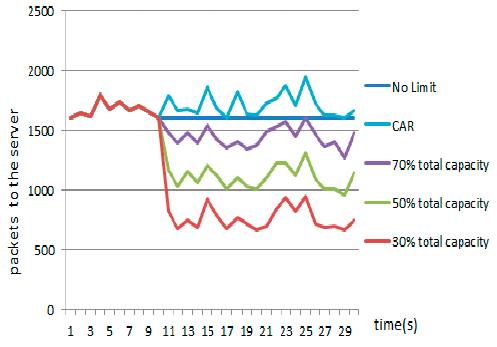
Sensors 2017 , 17 , 553 Figure 25. Comparison of the throughput under CAR/IMG. Figure 25. Comparison of the throughput under CAR/IMG.